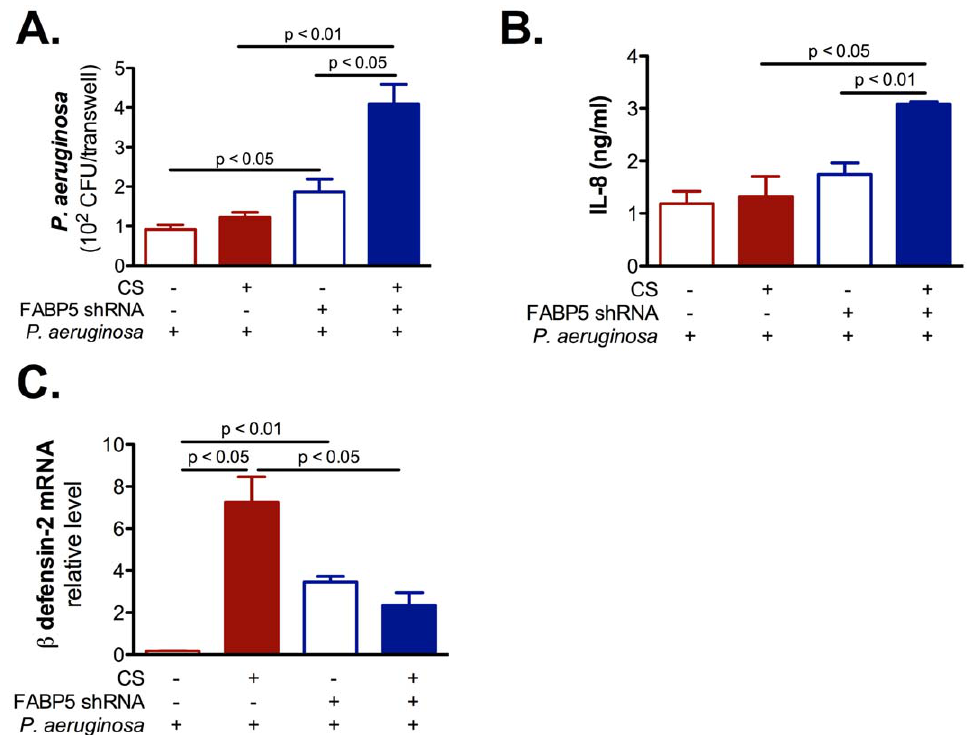
Figure 4. FABP5 down regulation increases inflammation but decreases innate immunity in primary NHBE cells. A. CS exposure increases P. aeruginosa colony forming units (CFU) on FABP5 knocked down primary NHBE cells. B. CS exposure significantly enhances IL-8 secretion in the basolateral supernatant of primary NHBE cell cultures knocked down for FABP5. C. CS exposure decreases b -defensin 2 mRNA expression on FABP5 knocked down primary NHBE cells. FABP5 shRNA 2 indicates cells that were knocked down for Firefly luciferase and FABP5 shRNA + indicates cells that were knocked down for FABP5. Data are representative of 3 independent experiments and are expressed as mean 6 SEM.